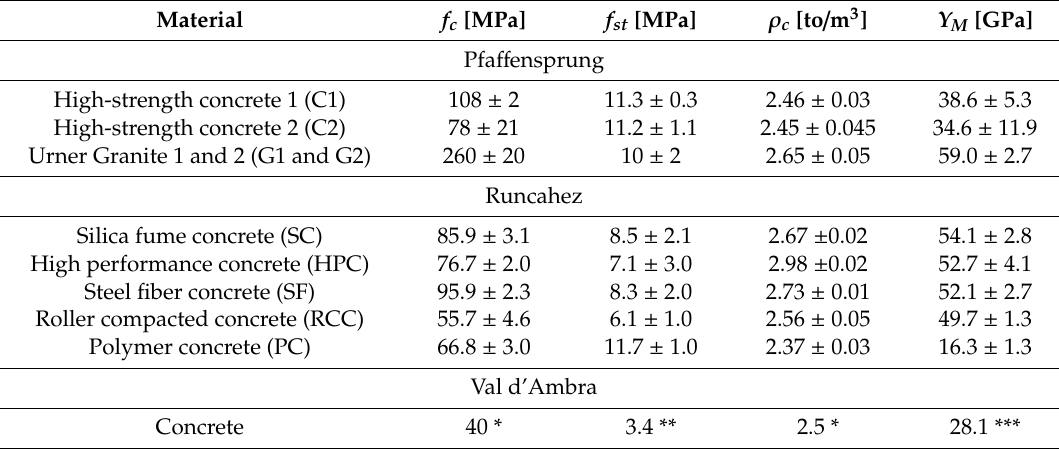
* ratio of reservoir volume to mean annual inflow volume; ** some SBTs have a flow acceleration section at the inlet with a larger slope and shorter length compared to the slope and length of the rest of the tunnel; *** four and two years for test location 1 and 2, respectively. Table 2. Properties of tested invert materials (mean value ± standard deviation) in the SBTs Pfa ff ensprung, Runcahez and Val d’Ambra (data from